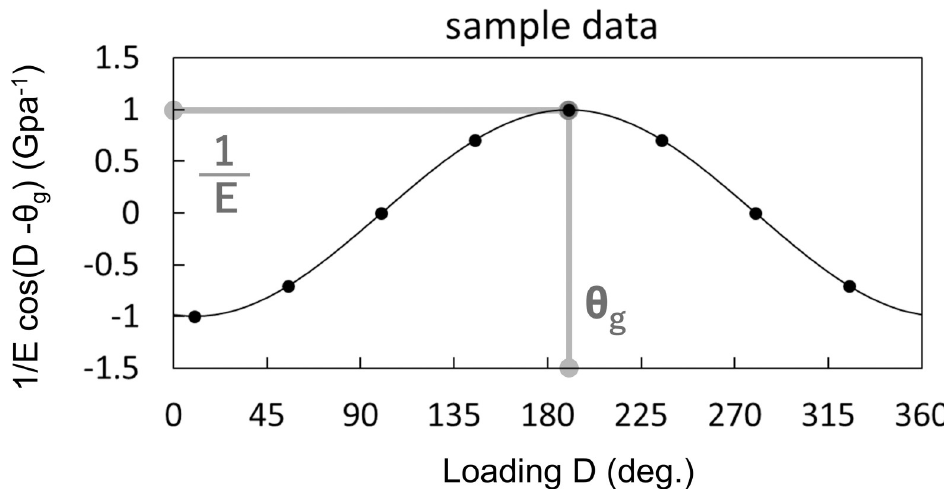
Fig 3. Schema of the fitted curve derived from the pulling test for eight directions. D shows the loading direction of the force from baseline. The phase shift of the curve gives θ g , and the amplitude of the curve gives 1/E.